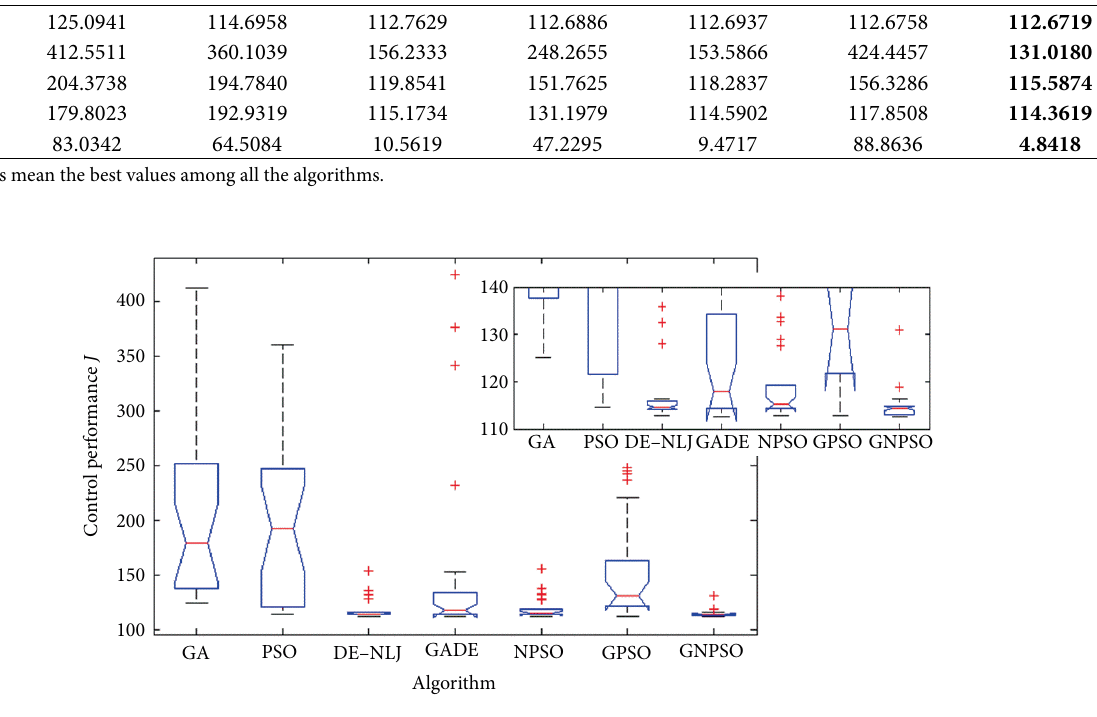
Table 12: Statistical results of the control performance using different algorithm for MIMO nonlinear wing vibration system.